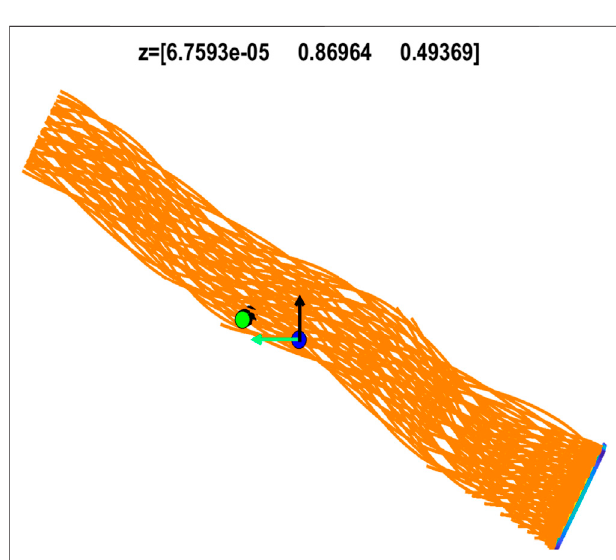
FIGURE 8 | The 3D view of the fi eld lines or the fl ux bundle of the Freidberg solution given in Figure 7B , from the same viewpoint and in the sameformatas Figure4 .The z axisorientationandthelocationsofWind(blue dot) and SO (green dot) spacecraft are also marked.